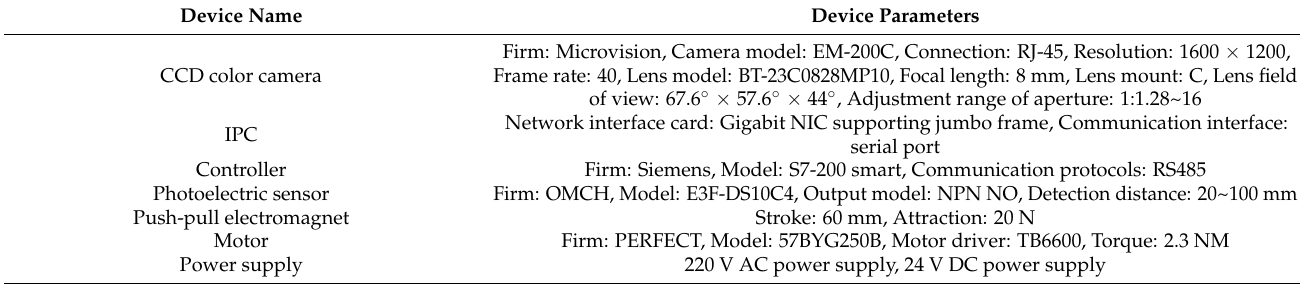
Figure 12. System work flow chart. Table 2. Hardware